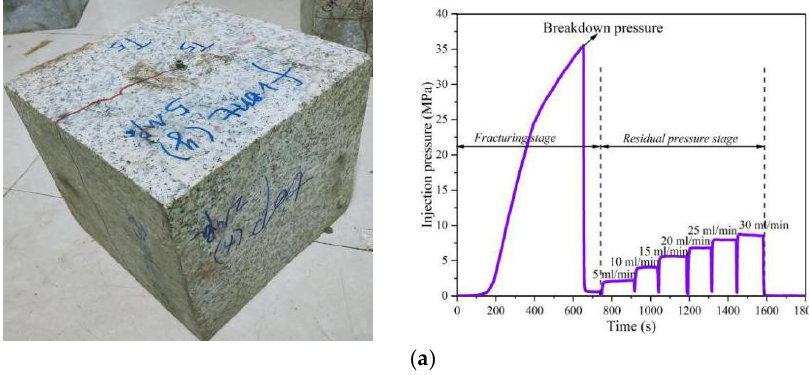
Figure 7. Fractured granodiorite samples and pressure-time curves for different injection rates. ( a ) G-1 sample (5 mL/min) and ( b ) G-2 sample (10 mL/min). Compared with granodiorite samples G-1 (5 mL/min) and G-2 (10 mL/min), the breakdown pressures of the monzogranite samples MG-4 (5 mL/min) and MG-5 (10 mL/min) were significantly higher at the same injection rates, and there were significantly more recorded AE